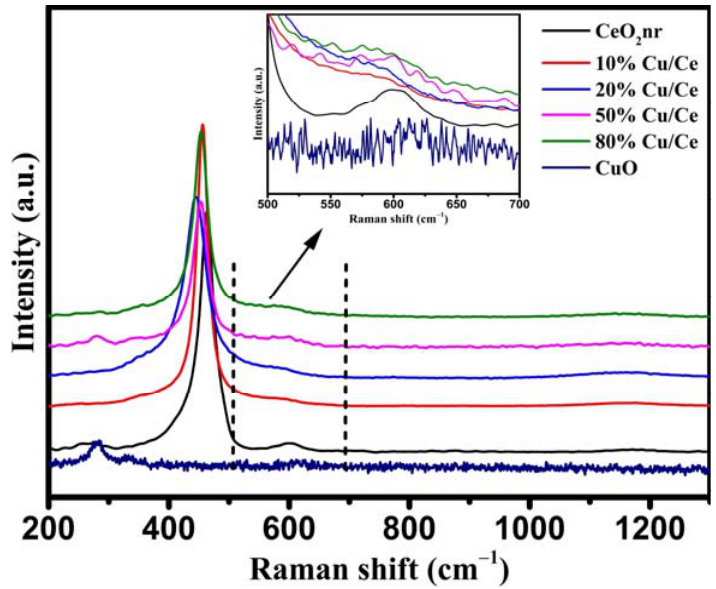
Figure 10. Raman spectra of the CeO 2 ‐ supported CuO catalysts.